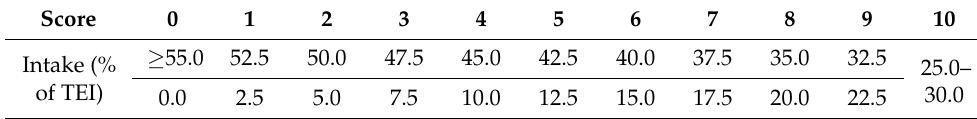
Table 5. Summary of score corresponding to total fat intake (% of